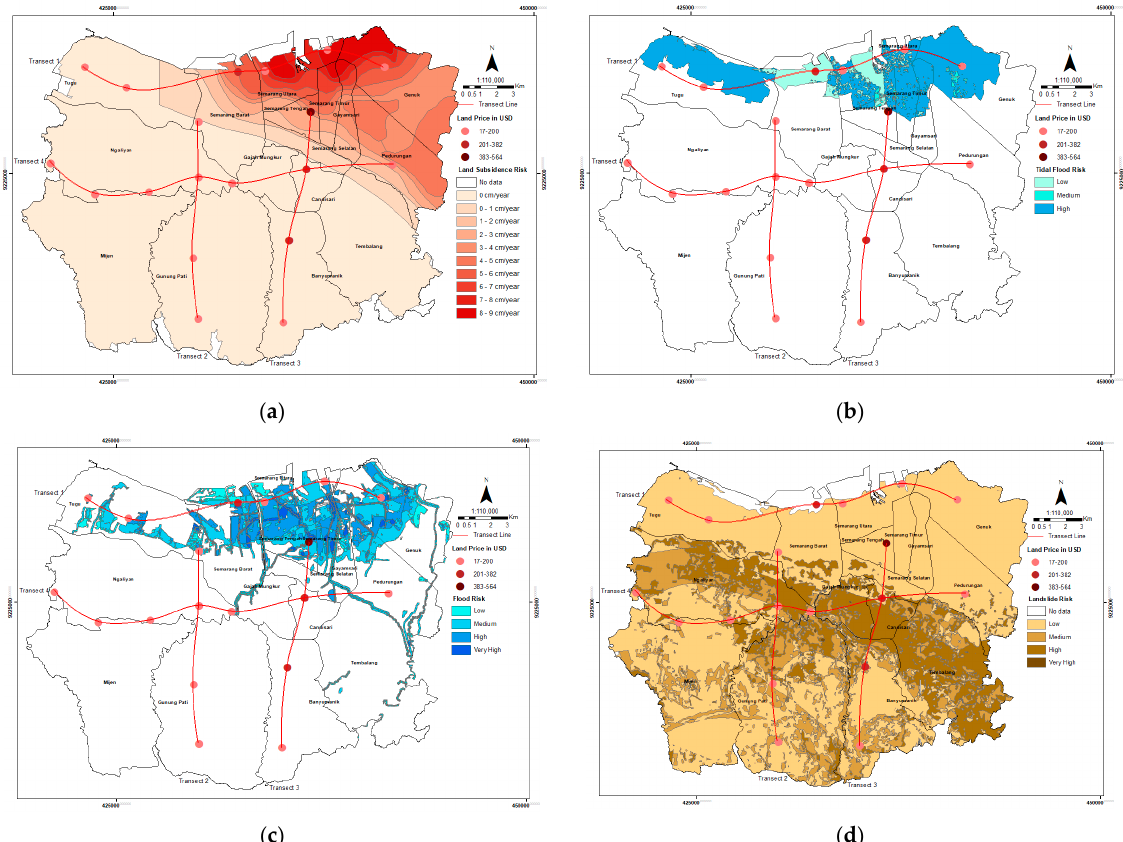
Figure 7. Distribution of land values and disaster risks: ( a ) Land subsidence; ( b ) tidal flood; ( c ) flood; and ( d ) landslides.